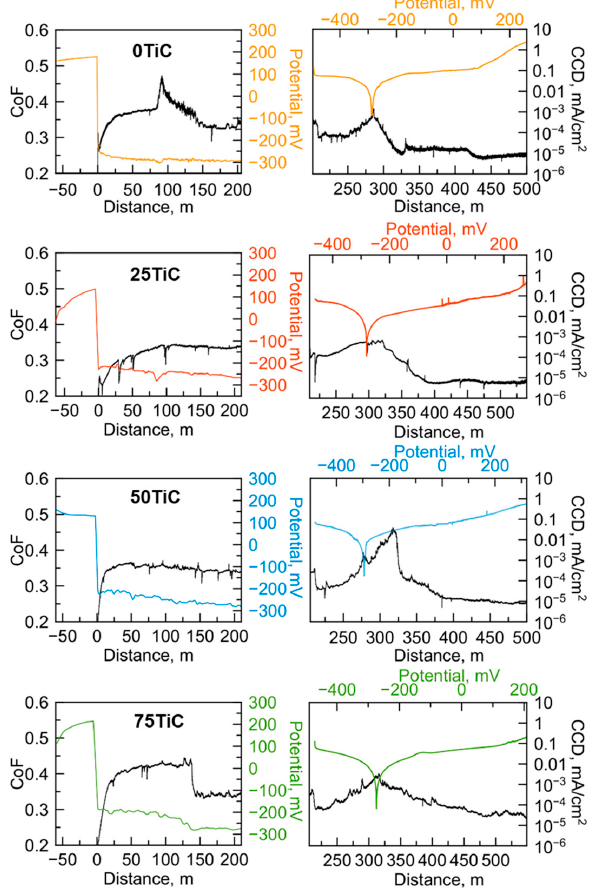
Figure 11. CoF and CCD vs. distance curves of the coatings tested against Al 2 O 3 in ASW during combined tribocorrosion and electrochemical experiments.